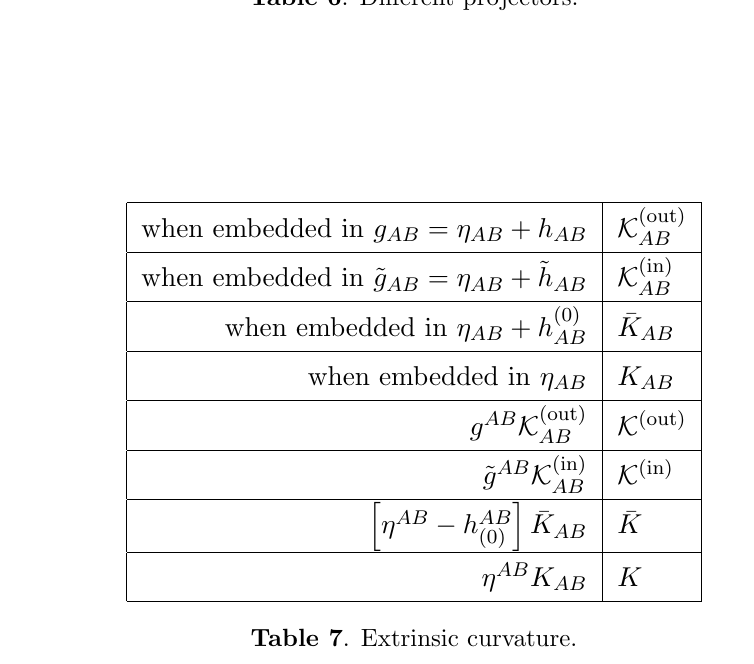
Table 6 . Di(cid:11)erent projectors.